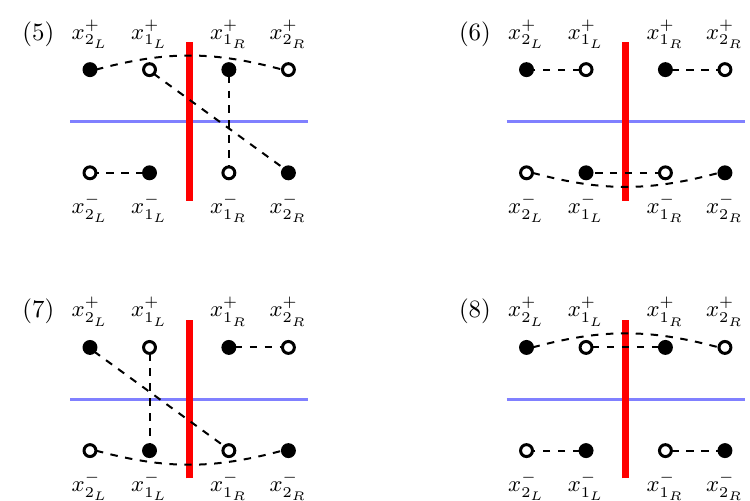
Figure 9 . Some additional channels contributing to the generic two-interval Rényi entropies in the TFD state.